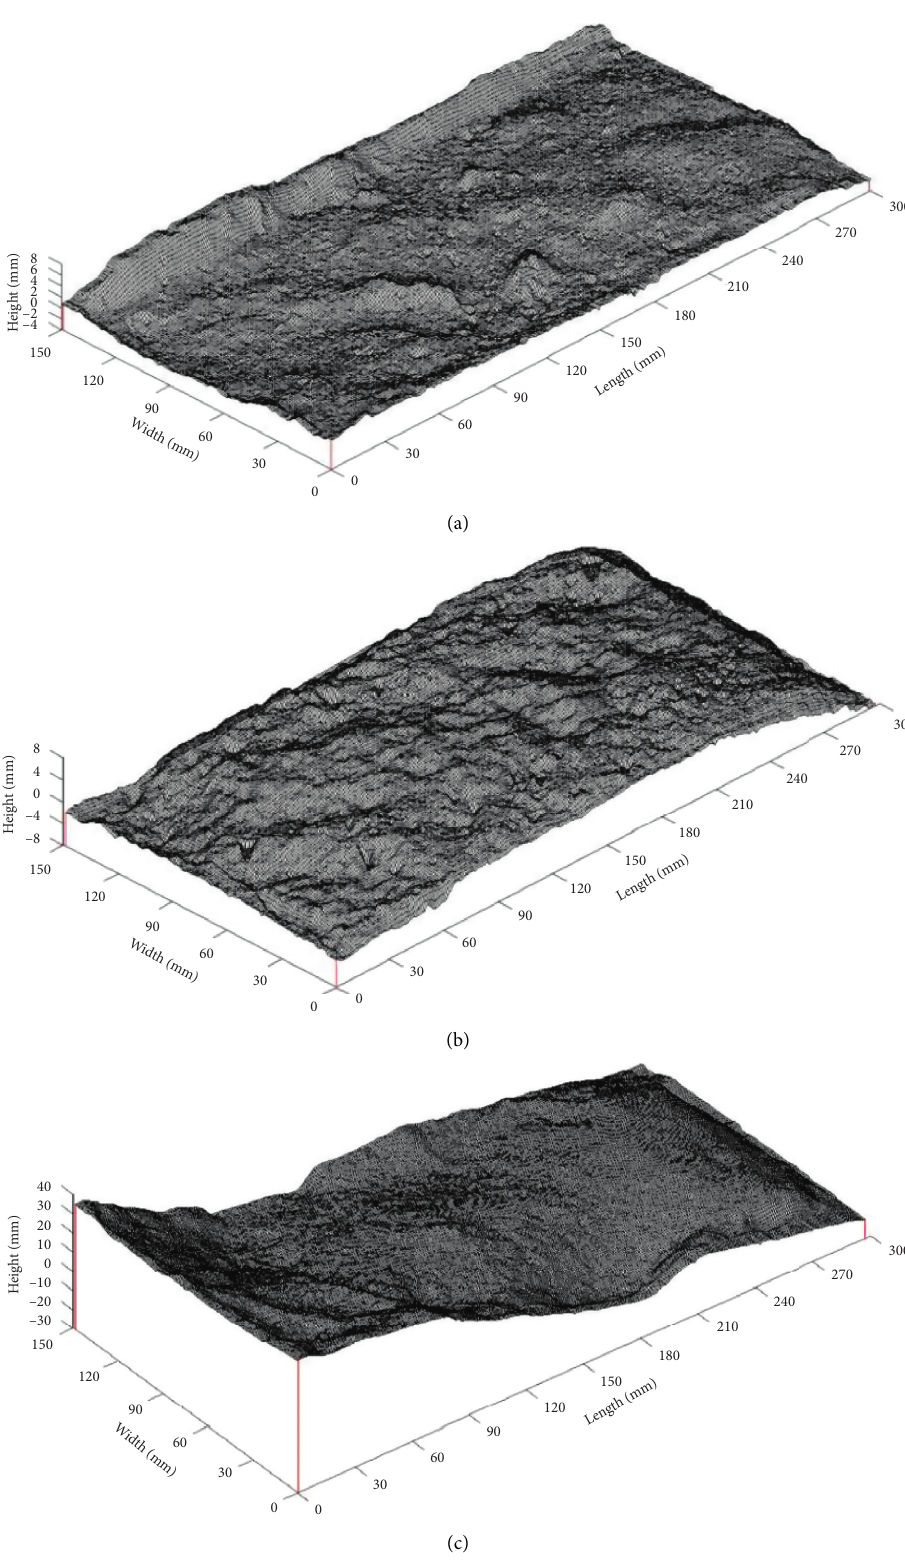
Figure 1: Morphology of the three rock joints. (a) J-I. (b) J-II. (c)